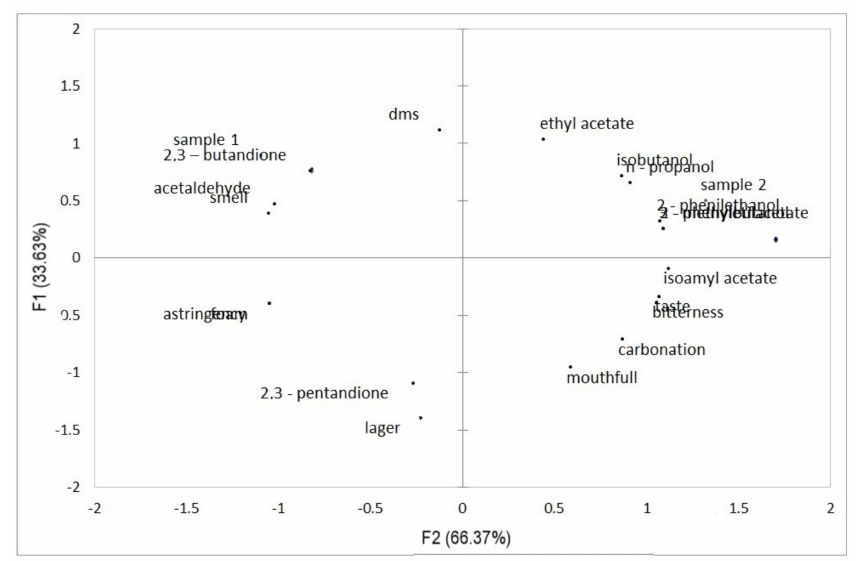
Figure 2. PCA (principal component analysis biplot) of volatile compounds found in analyzed beers and sensory